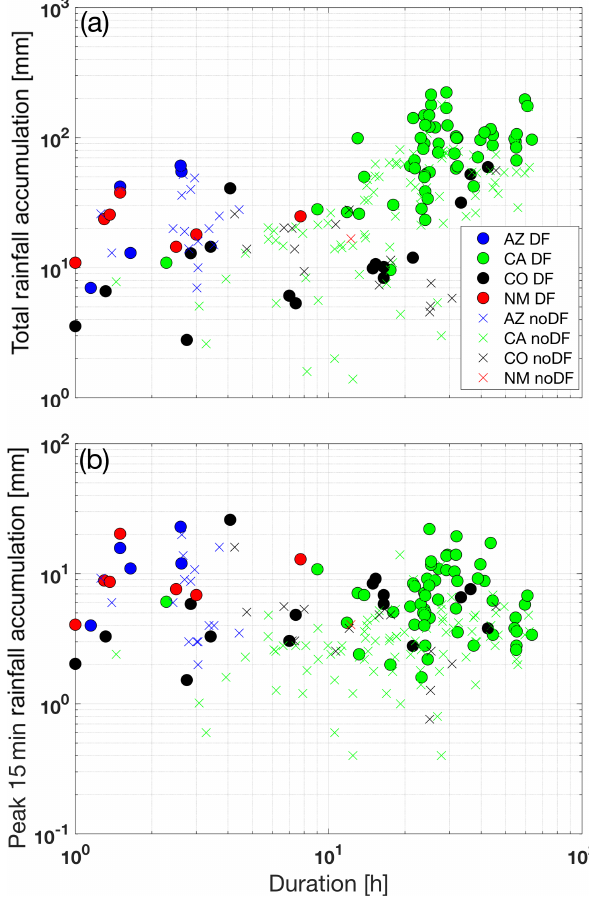
Figure 3. (a) Total rainfall accumulation vs. duration and (b) peak 15min rainfall accumulation vs. duration for Arizona, California, Colorado and New Mexico. Colored dots and x symbols correspond to DF and noDF occurrences,